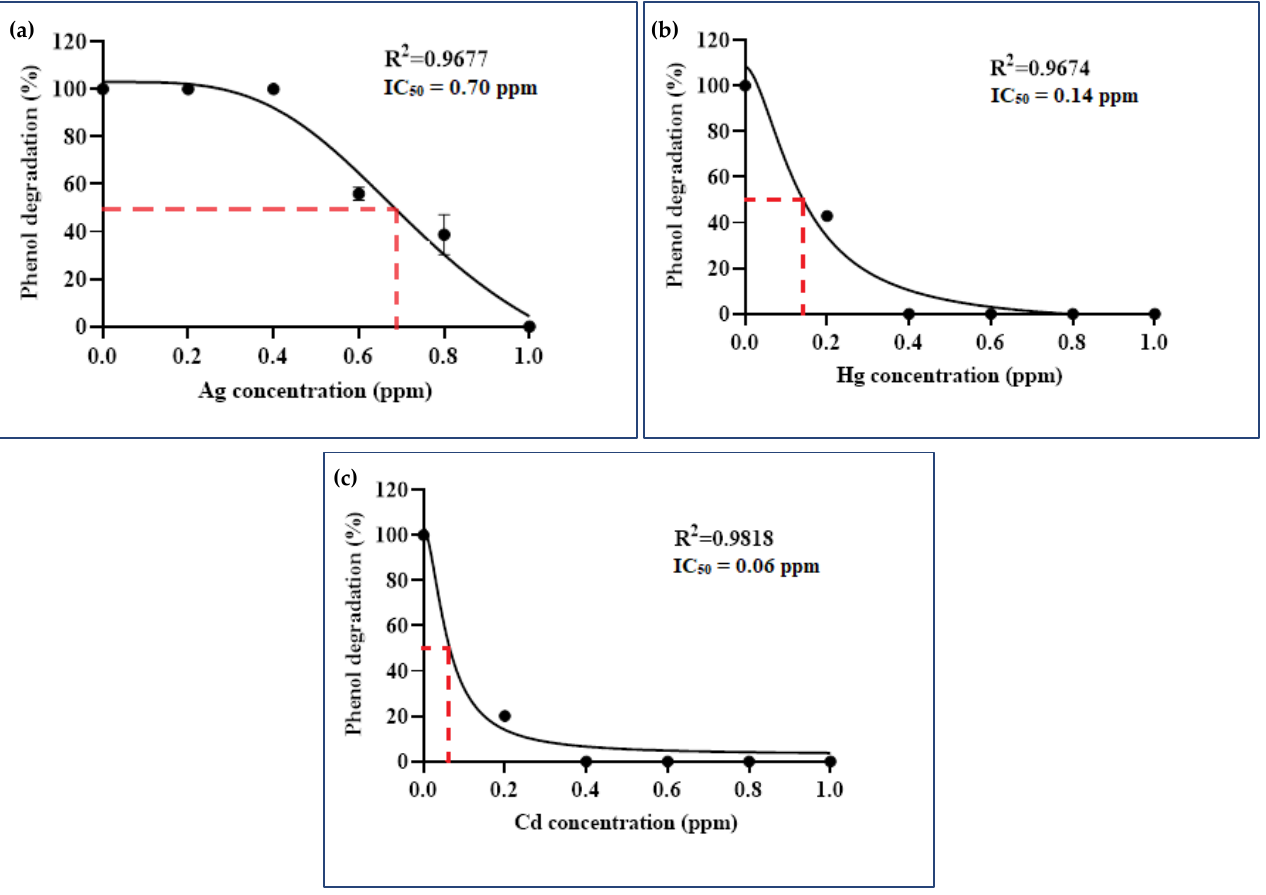
Figure 9 . Dose-response curves indicating IC 50 values for Arthrobacter sp. strain AQ5-15 phenol degradation after 96-h exposure to different concentrations of ( a ) Ag, ( b ) Hg, and ( c ) Cd.